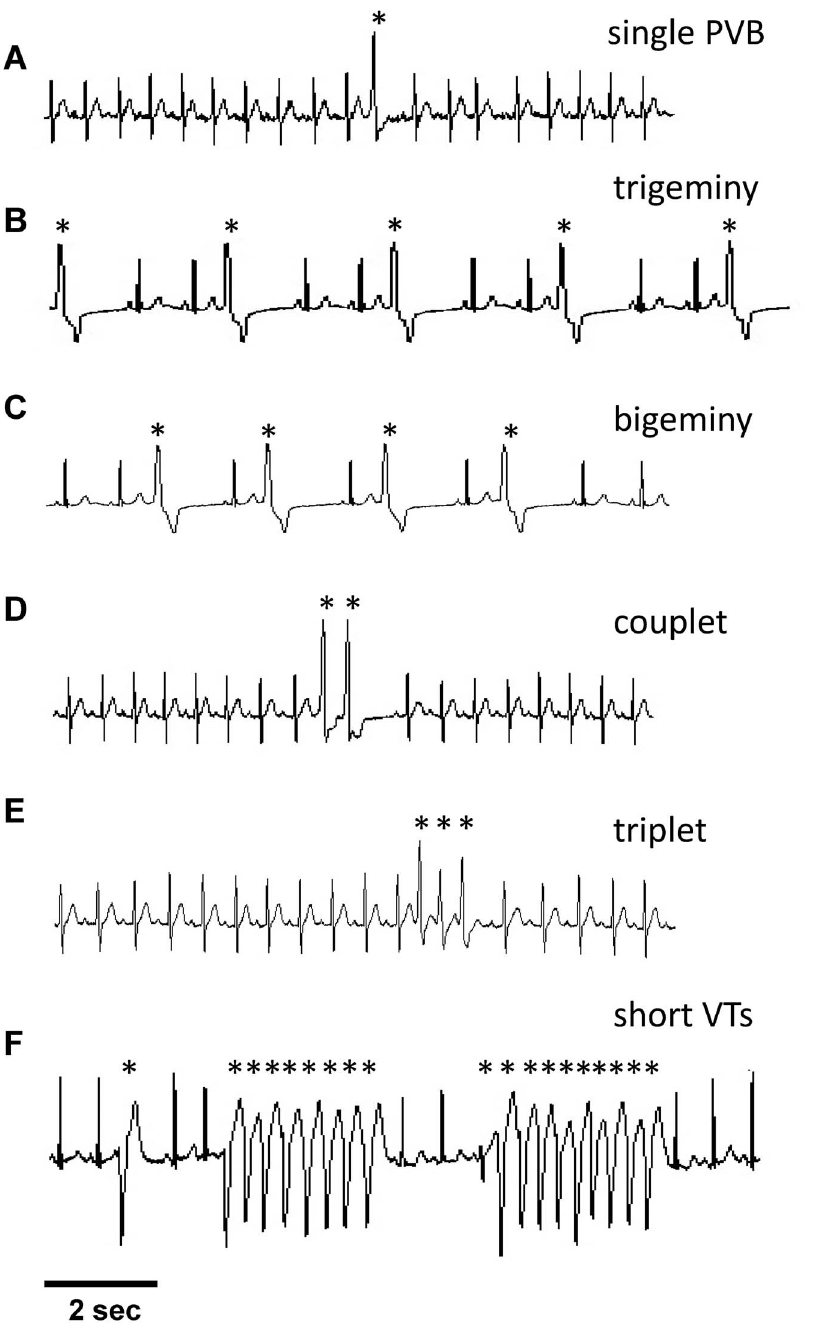
Figure 2. Typical experimental ECG recordings showing the different arrhythmias taken into account by our model. A) single premature ventricular beat; B) trigeminy complexes; C) bigeminy complexes; D) couplet episode; E) triplet episode; F) two short runs of tachyarrhythmias. In all cases, markers highlight arrhythmic complexes.